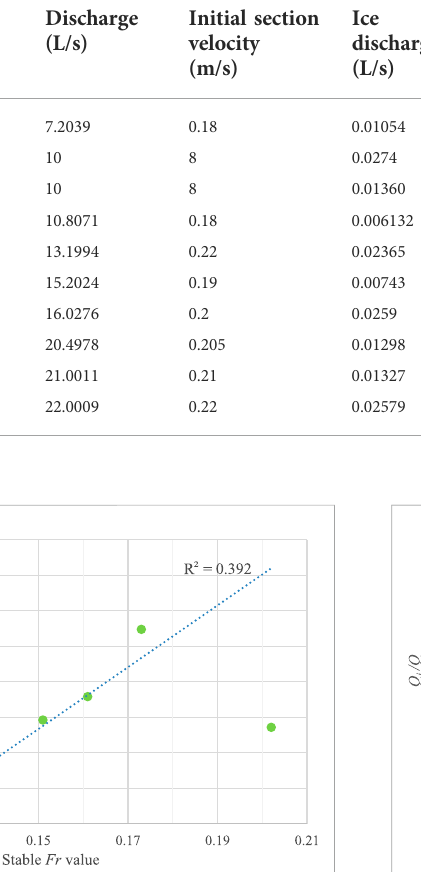
FIGURE 8 Partition result diagram of ice jam accumulation with different